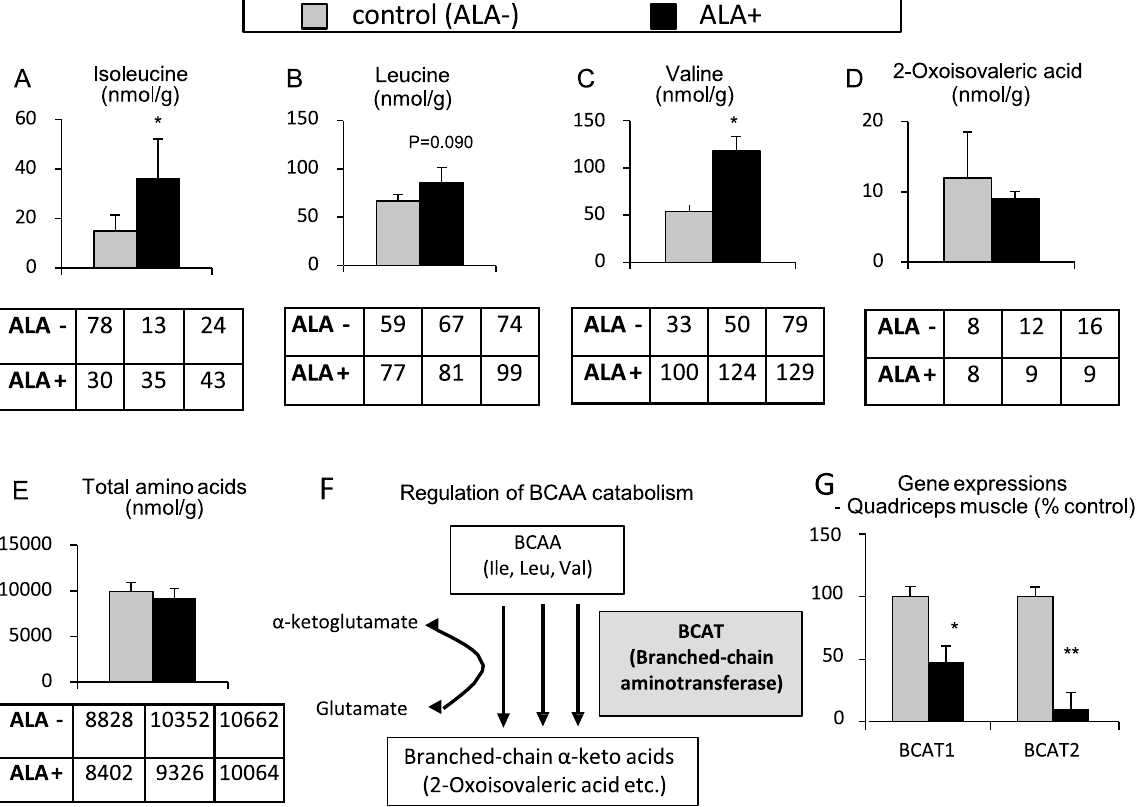
Figure 3. Branched-chain amino acids increase in the skeletal muscle of 5-aminolevulinic acid-treated mice. ( A – E ) Metabolome analysis in the quadriceps muscle ( A ) Isoleucine, ( B ) Leucine, ( C ) Valine, ( D ) 2-Oxoisovaleric acid, ( E ) Total amino acids), ( F ) Schematic representation of the regulation of BCAA catabolism by BCAT, ( G ) Gene expressions of BCATs estimated by quantitative PCR analysis (BCAT1, BCAT2). N = 3 in each group. * P < 0.05, ** P < 0.01 versus control group. ALA, 5-aminolevlinic acid; BCAA, branched chain amino acid; BCAT, branched-chain amino acid